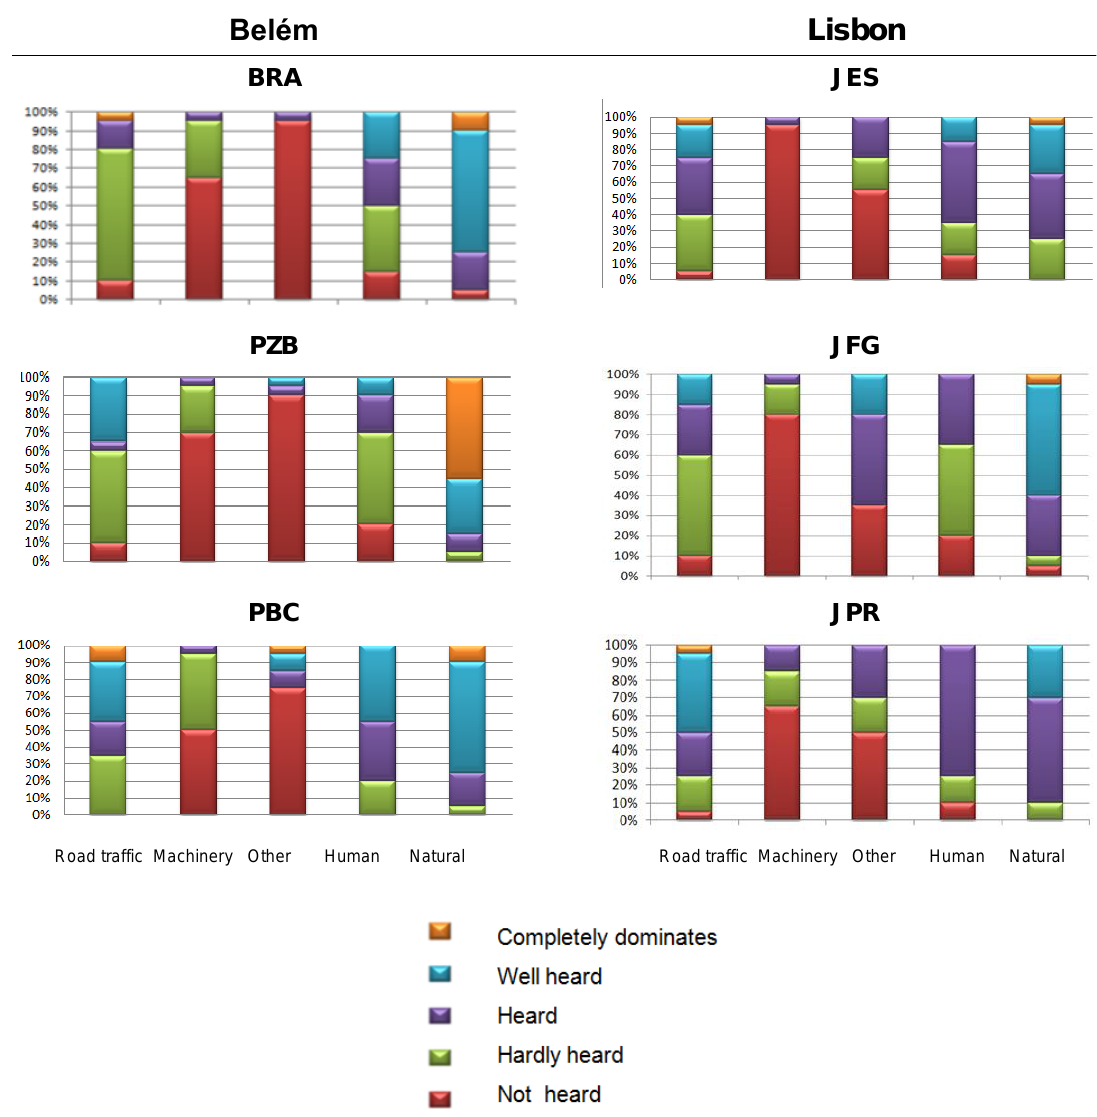
Figure 8: Evaluation of sound environment by park